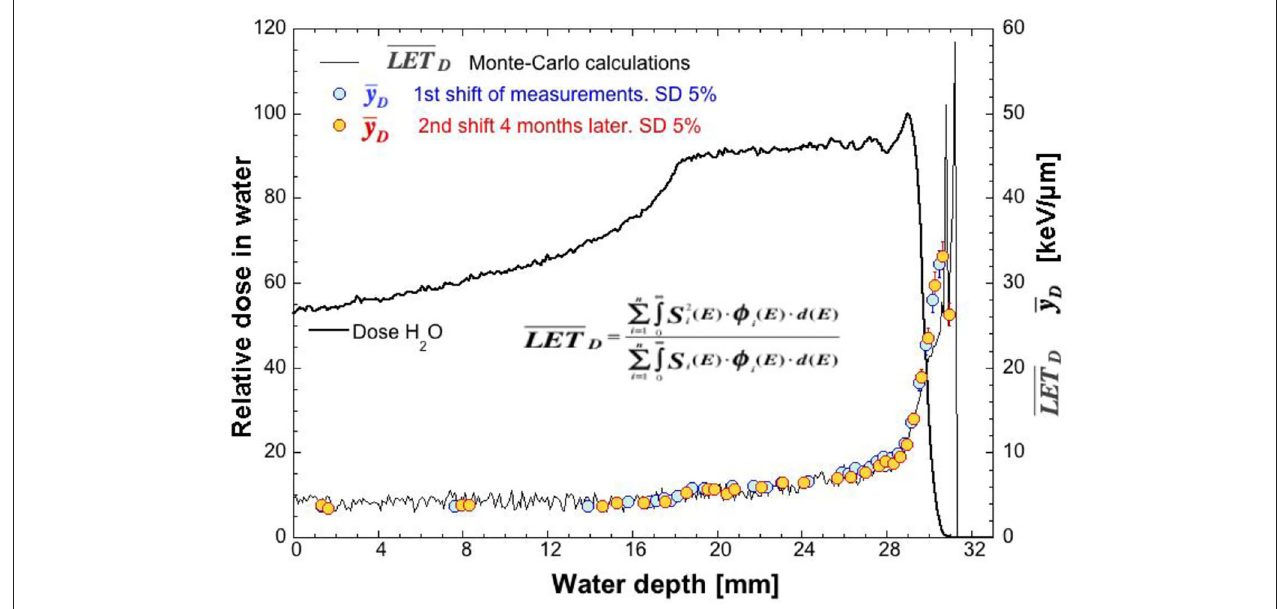
FIGURE 6 | y D values [measured with the mini-tissue-equivalent proportional counter (TEPC)] and dose-averaged linear energy transfer ( LET D ) values (calculated with the Geant4 Monte Carlo code) at different water depths in the CATANA therapeutic proton facility (taken from ICRU [ 29]). The large statistical fluctuations of the Monte Carlo calculation at the highest depths are due to the limited number of particles reaching those depths. In the insert, the formula used to calculate LET D is shown.